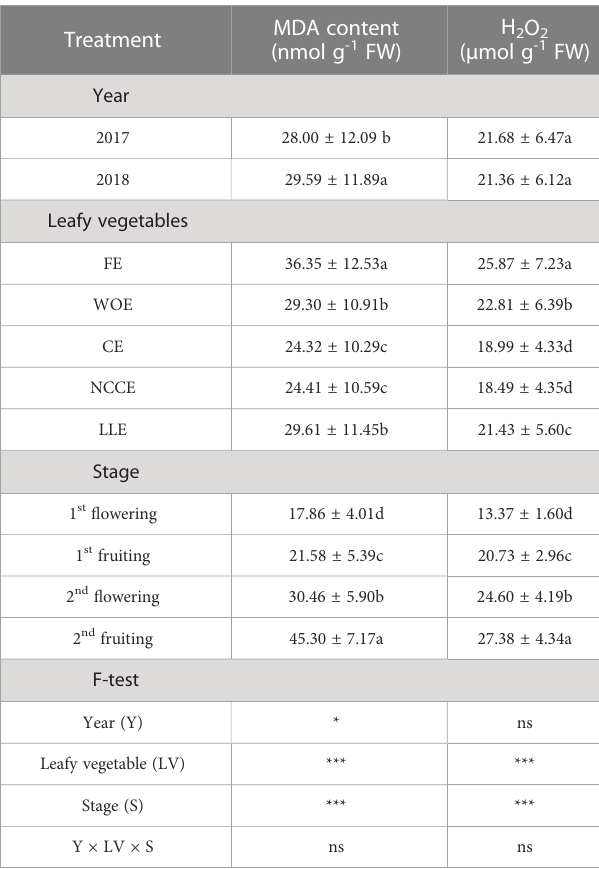
TABLE 5 Effect of different leafy vegetable rotation systems on the oxidative markers of eggplant at different growth stages during the year 2017 and